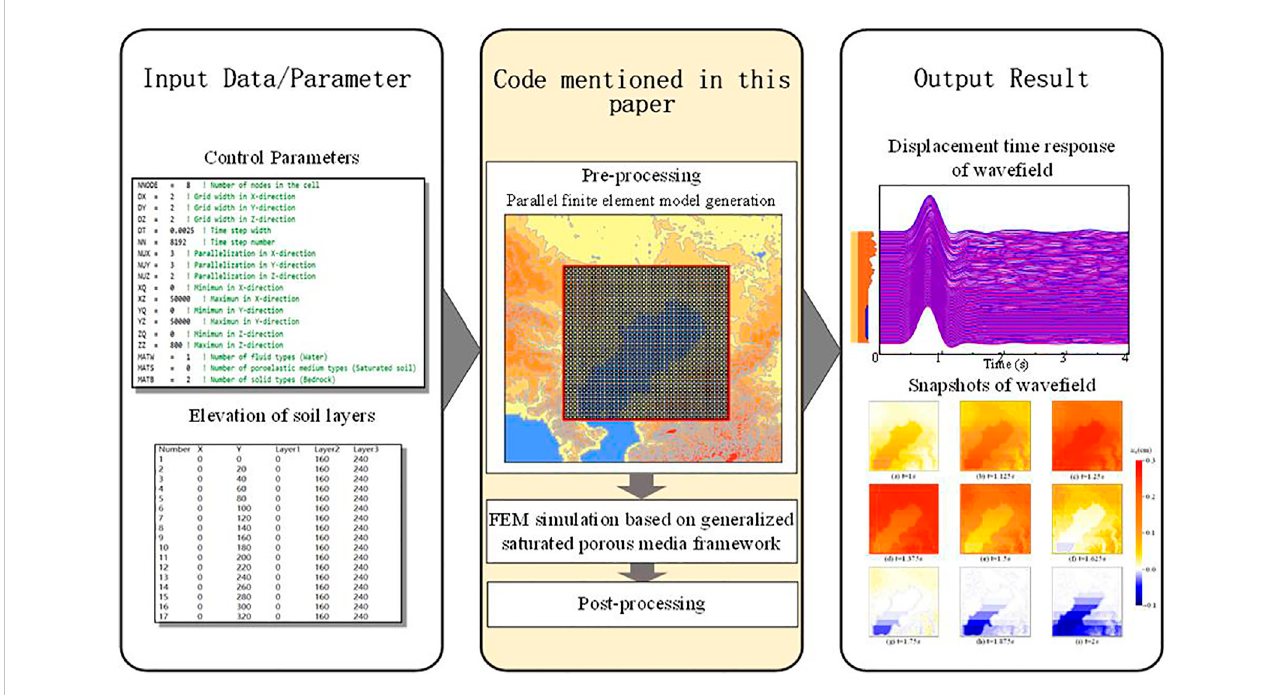
FIGURE 2 Aschematicillustration ofthe fl owofthewave propagation simulation usingthecodepresented inthispaper[Reproducedfrom Figure 1ofTakutoetal. (2017) with modi fi